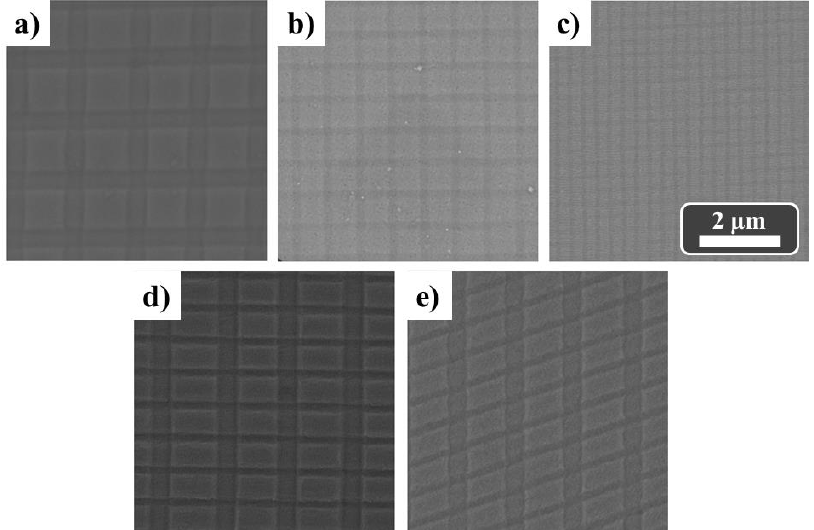
Figure 4. SEM images of square patterns on the Al substrate after two imprint steps using CD-PS/ML ( a ), DVD-PS/ML ( b ) and BR-PS/ML ( c ) molds. SEM images of rectangular and rhombohedral patterns on Al substrate after two imprint steps combining CD- PS/ML and DVD- PS/ML molds and when the mold was rotated for the second imprint process by 90° ( d ) and 60° ( e ). 2.3. PAA Nanostructures Grown by Anodization of Imprint-Patterned Al